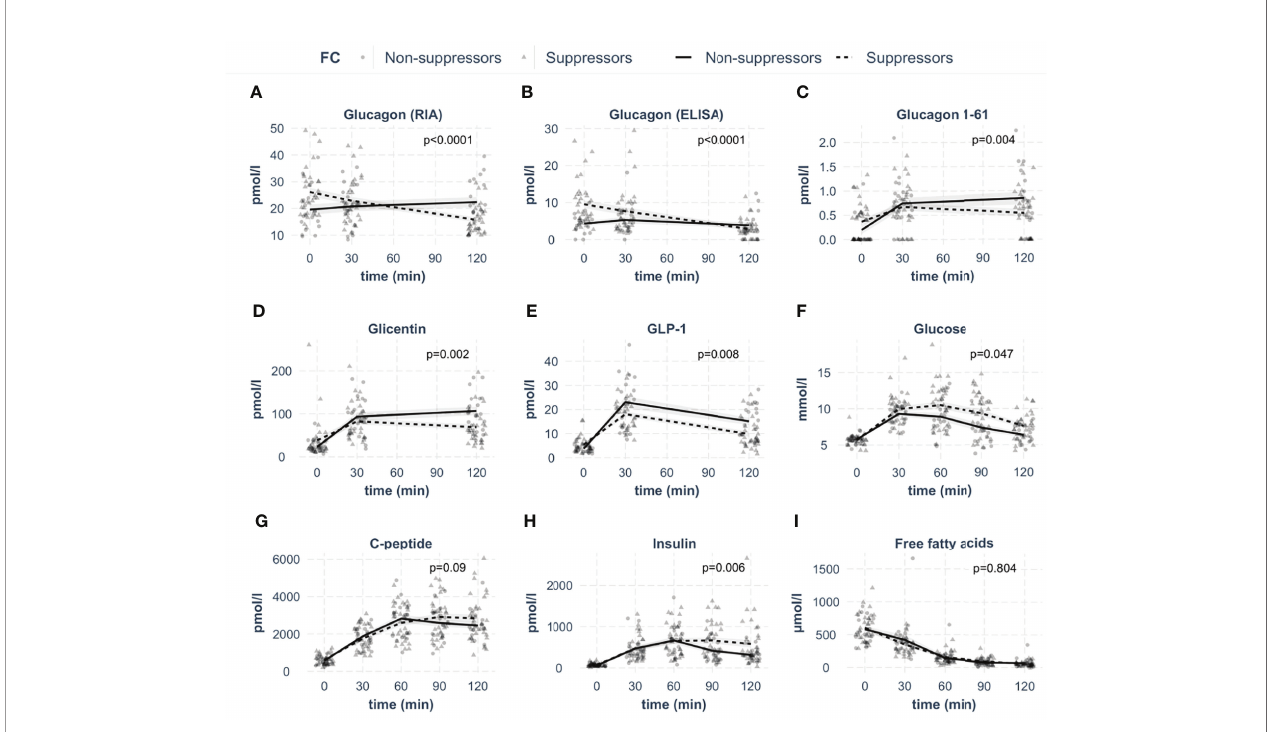
FIGURE 2 | Concentrations of investigated analytes in the groups of glucagon suppressors and non-suppressors during the OGTT. The respective analyte is indicated in the box. ( A : glucagon measured by radioimmunoassay, B : glucagon measured by ELISA, C : glucagon 1-61, D : glicentin, E : GLP-1, F : glucose, G : C- peptide, H : insulin, I : free fatty acids). Lines represent means with standard errors. Circles indicate data points for suppressors, triangles for non-suppressors, p- values were calculated with linear mixed models.